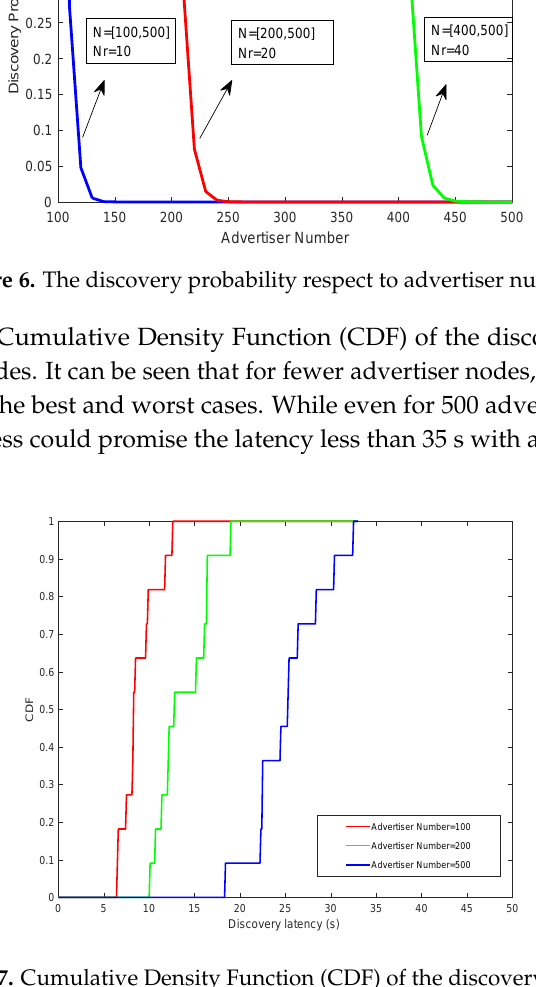
Figure 7. Cumulative Density Function (CDF) of the discovery